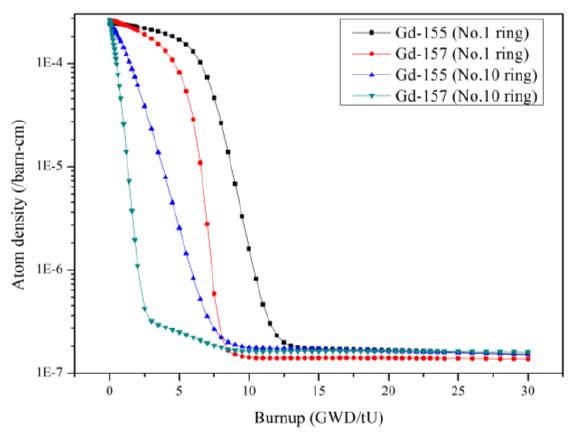
Figure 5. Comparison of k inf for 3 (cid:221)(cid:221) 3 pins with gadolinia.